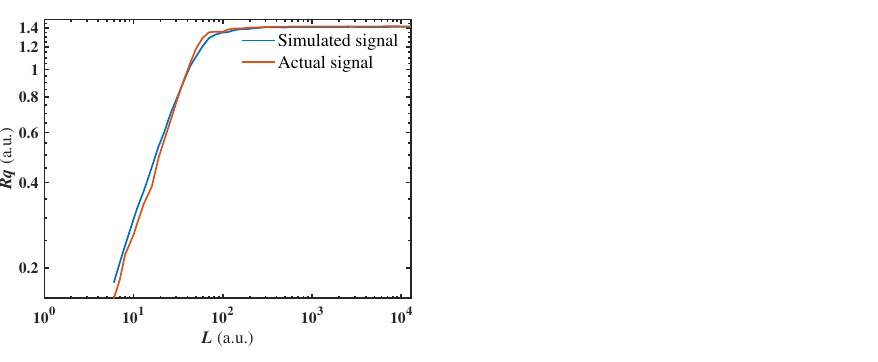
Figure 15. The comparison of Rq - L curves of the actual signal and the simulated